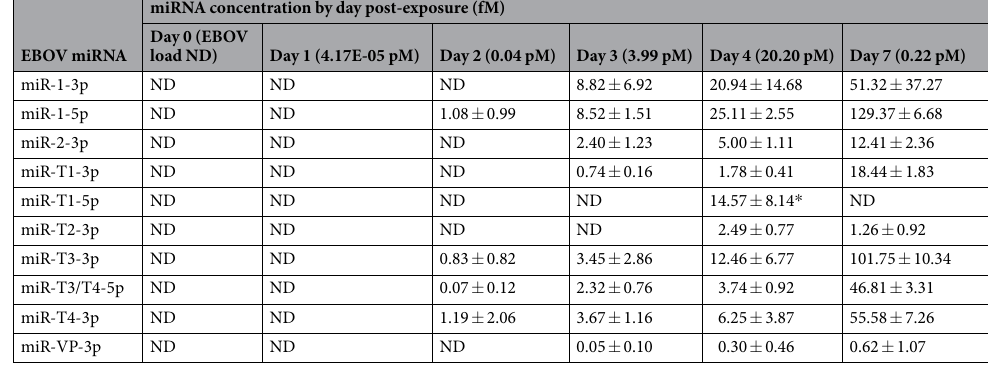
Table 3. EBOV miRNAs were detected in BALB/c mice intraperitoneally injected with mouse-adapted EBOV/ Mayinga. Note: Data are presented as the mean ± SD of biological replicates assayed in technical triplicate. Values in bold font indicate amplification in only one of three biological samples, with mean ± SD only for that sample. The corresponding EBOV load at each timepoint is given in parentheses below each day. ND = not detected. * Value given is based on the mismatched miR-T1-5p